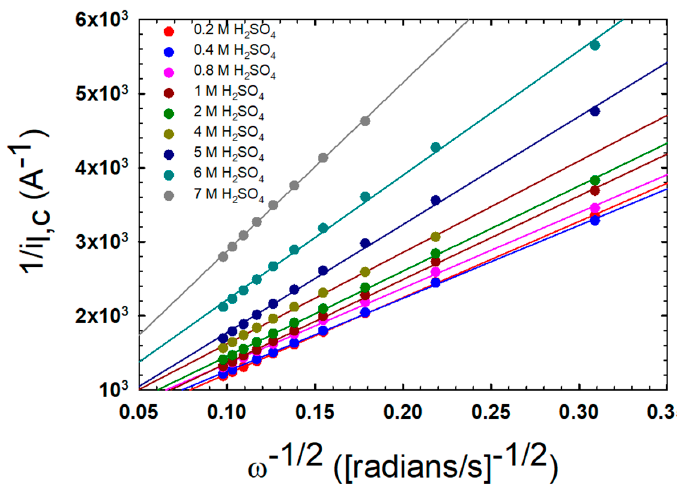
Figure 4. Results of the Koutecky–Levich (K–L) analysis of linear sweep voltammetry data measured for 0.01 M VO 2+ in the indicated H 2 SO 4 solutions at 25 °C.